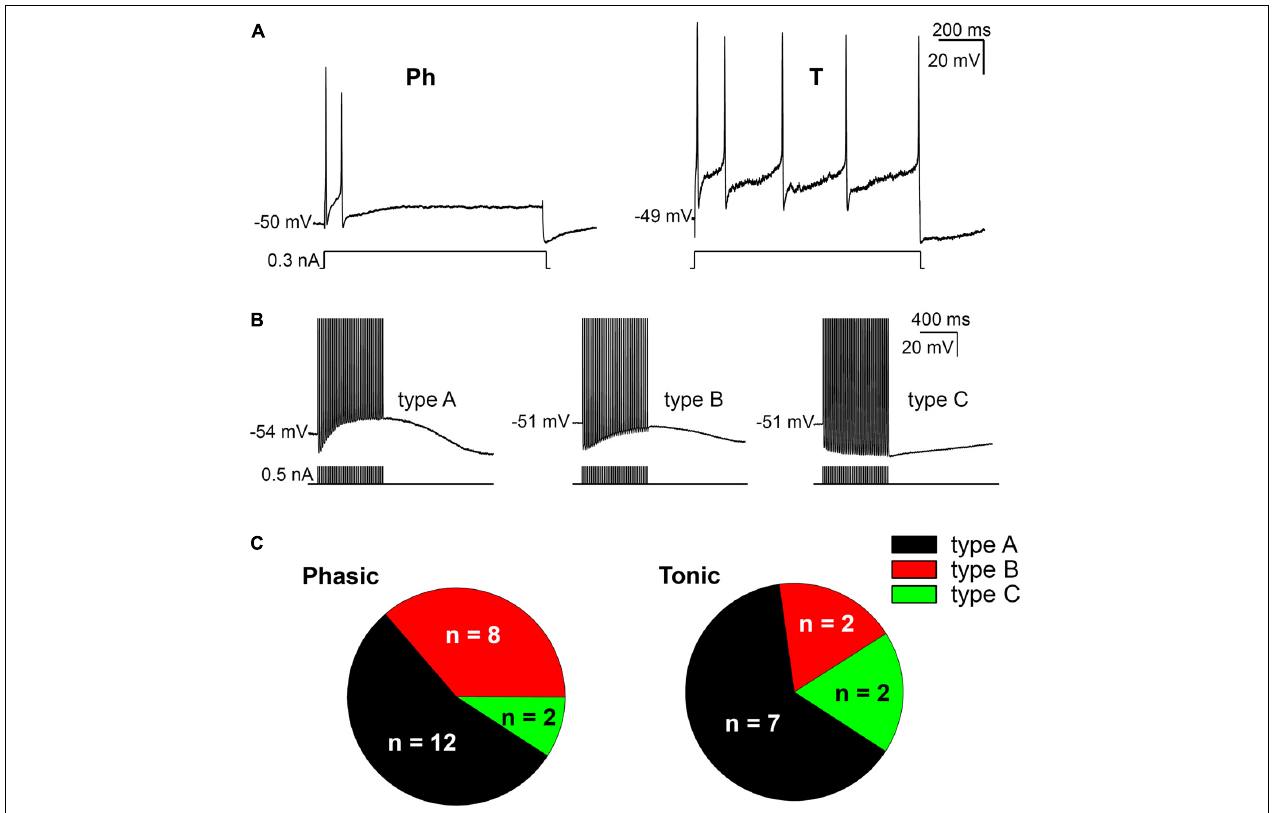
FIGURE 1 | Firing patterns and afterpotentials of mouse sympathetic neurons. (A) Phasic (Ph) firing behavior of a cell in response to a depolarizing pulse (0.3 nA, 1 s) and cell showing a tonic (T) response to a similar depolarization. In both cases, pulse amplitude was less than 1.5 times the rheobase. The resting membrane potential (RMP) of cells is indicated at the beginning of each recording. Calibration bars apply to both panels (as in B ). (B) Classification of cells according to their afterpotentials: with clear ADP after the train (type A); with a certain degree of CaCC activation, although the concomitant activation of I K ( Ca ) results in a negative afterpotential 50 ms after the end of the train, but more positive than the AHP of the first spike (type B); finally, with a clear AHP after the train, similar to those of the individual spikes (type C). Action potentials (APs) were evoked with short (5 ms) intracellular current pulses at 35 Hz shown in each recording below the membrane potential. Spikes are truncated at the top. (C) Differential distribution of the three neuron types showed in B in both Ph and T SCG